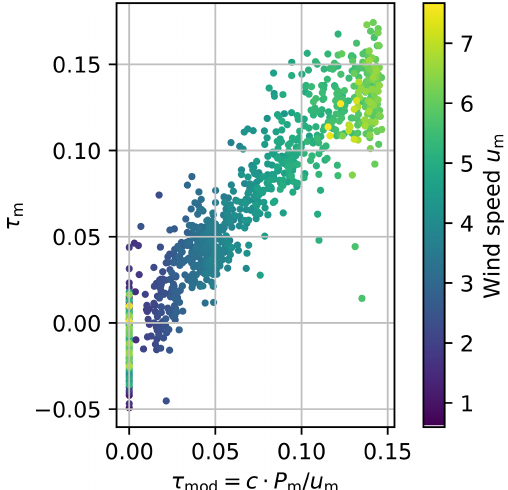
Figure 14. Comparison of the modelled tilt angle τ mod of the tran- sition piece platform estimated by the PTM ( x axis) to the measured tilt angle τ m derived from the roll ρ m and pitch φ m angles measured by the SSL ( y axis) in a scatter plot. The colour of the scatter points represent the wind speed measured by the turbine